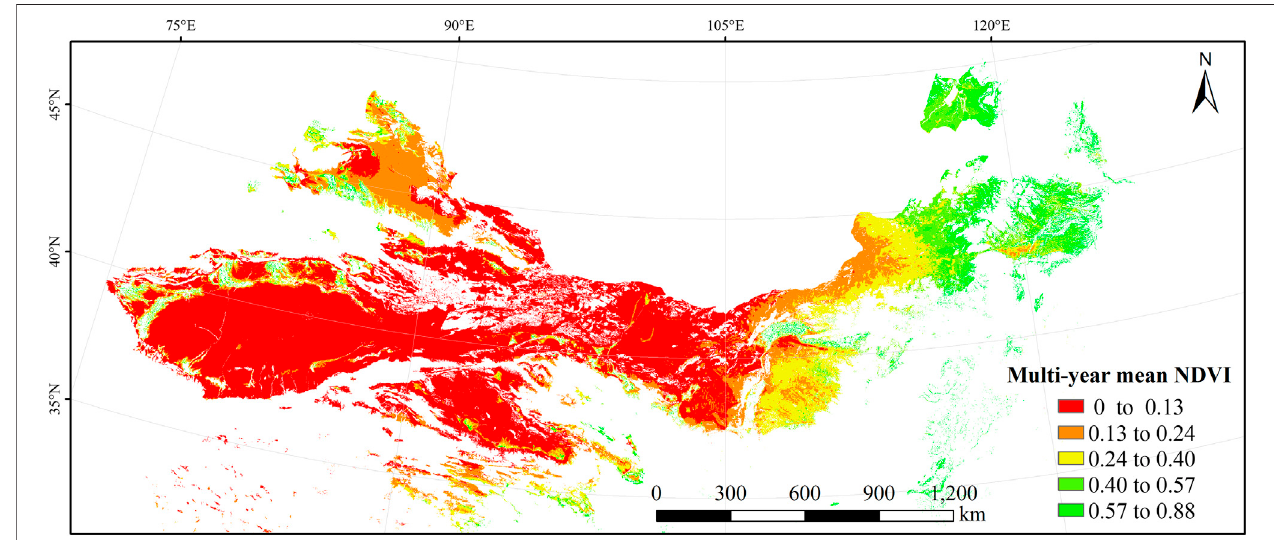
FIGURE 2 | Spatial distribution of the multi-year mean normalized-difference vegetation index (NDVI) of the deserti fi ed area of China from 1998 to 2015. The NDVI intervals were calculated using the natural-breaks method provided by ArcMap.